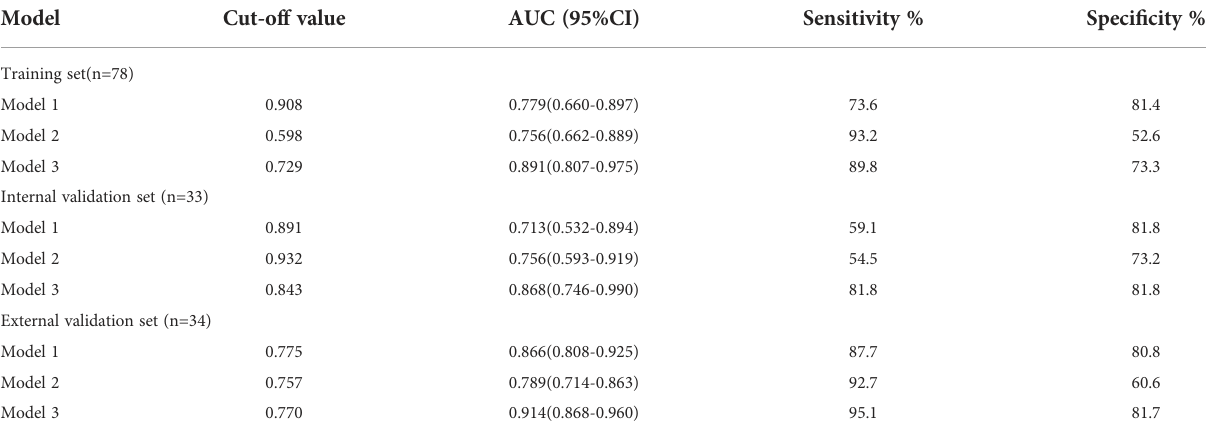
TABLE 5 Diagnostic performance of three